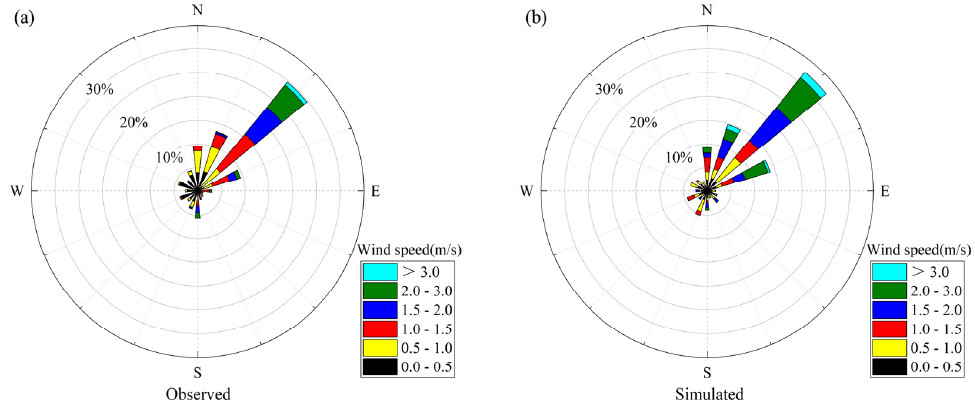
Figure 4. The wind roses obtained by observation ( a ) and simulation ( b ) at the Caotang observation site in January 2019.